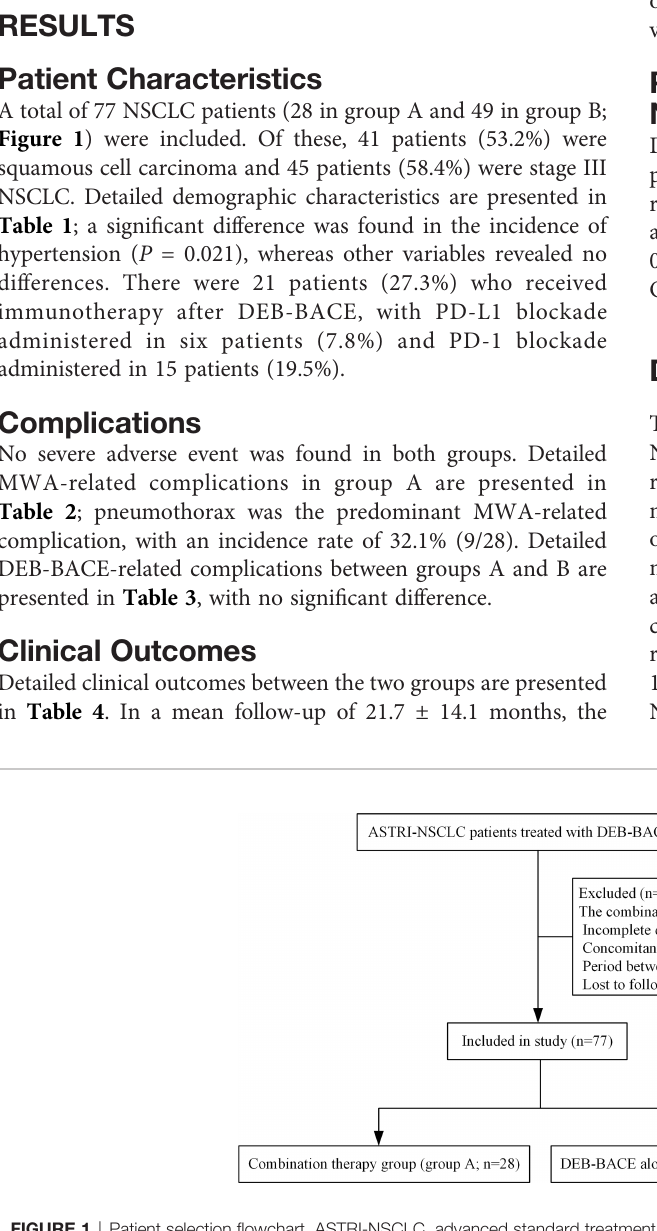
FIGURE 1 | Patient selection fl owchart. ASTRI-NSCLC, advanced standard treatment-refractory/ineligible non-small cell lung cancer; DEB-BACE, drug-eluting bead bronchial artery chemoembolization; MWA, microwave ablation; BAI, bronchial artery infusion